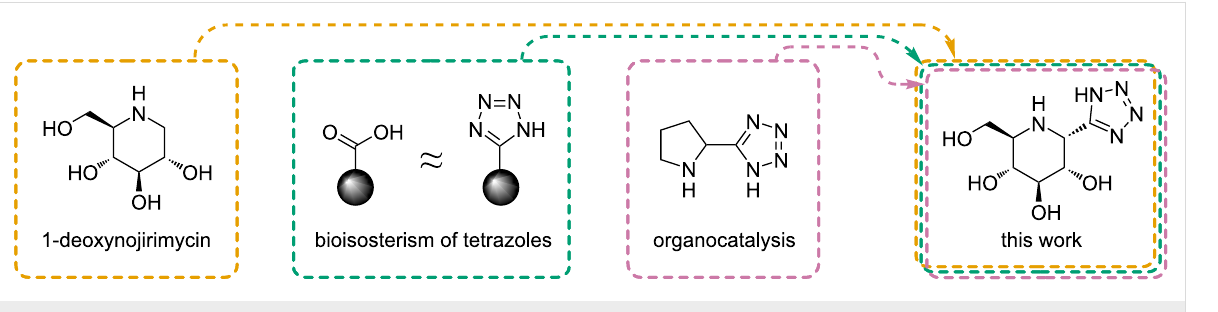
Figure 1: Key concepts behind the goal of this work